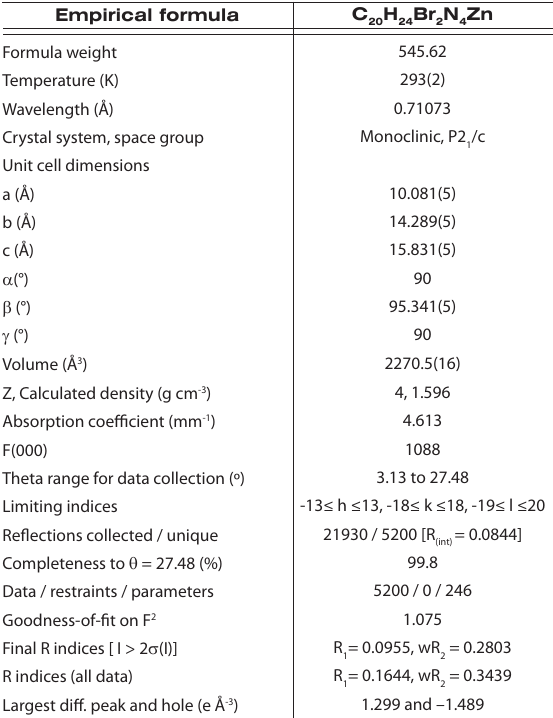
H -bim) Br ] 3 7 2 2